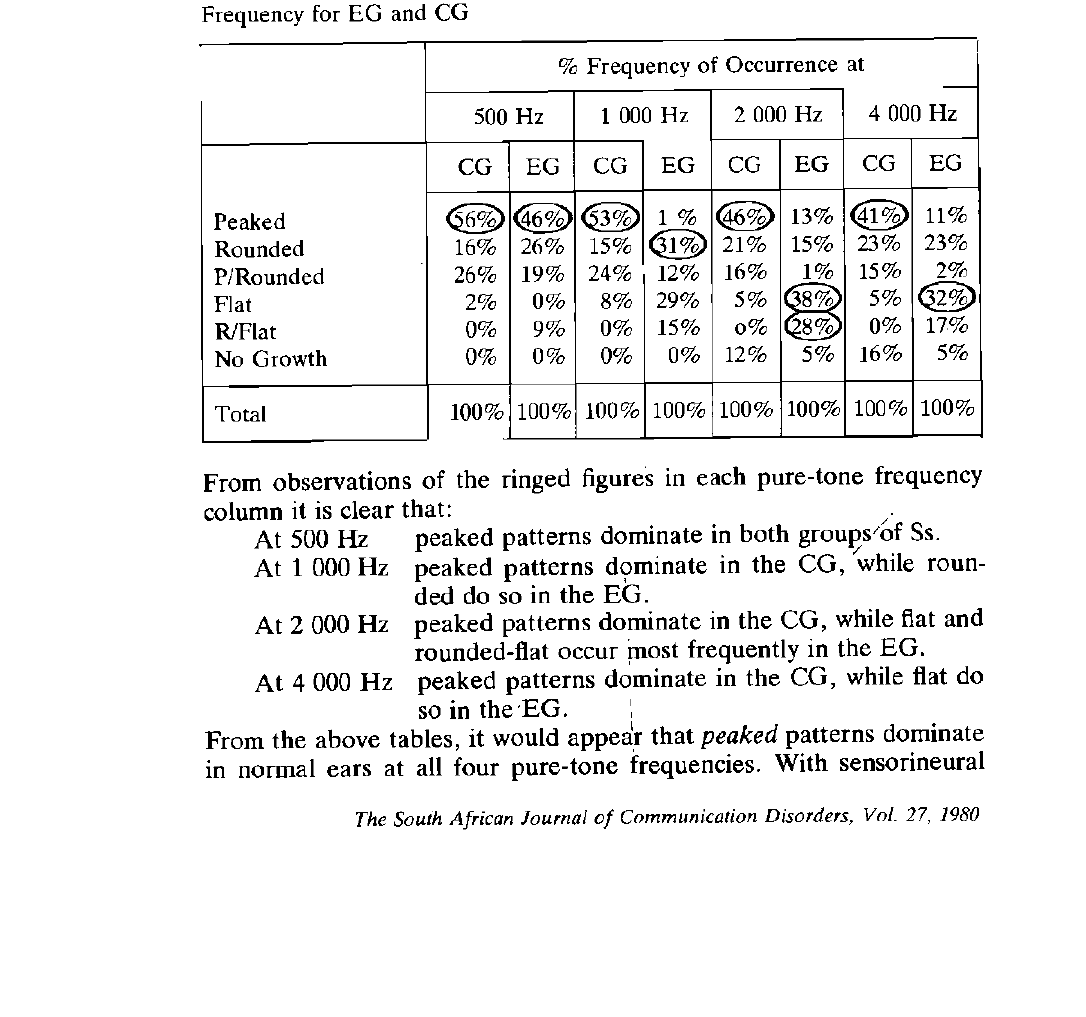
TABLE IV: Relative % Frequency Distribution of ARGP's at each Pure-Tone Frequency for EG and